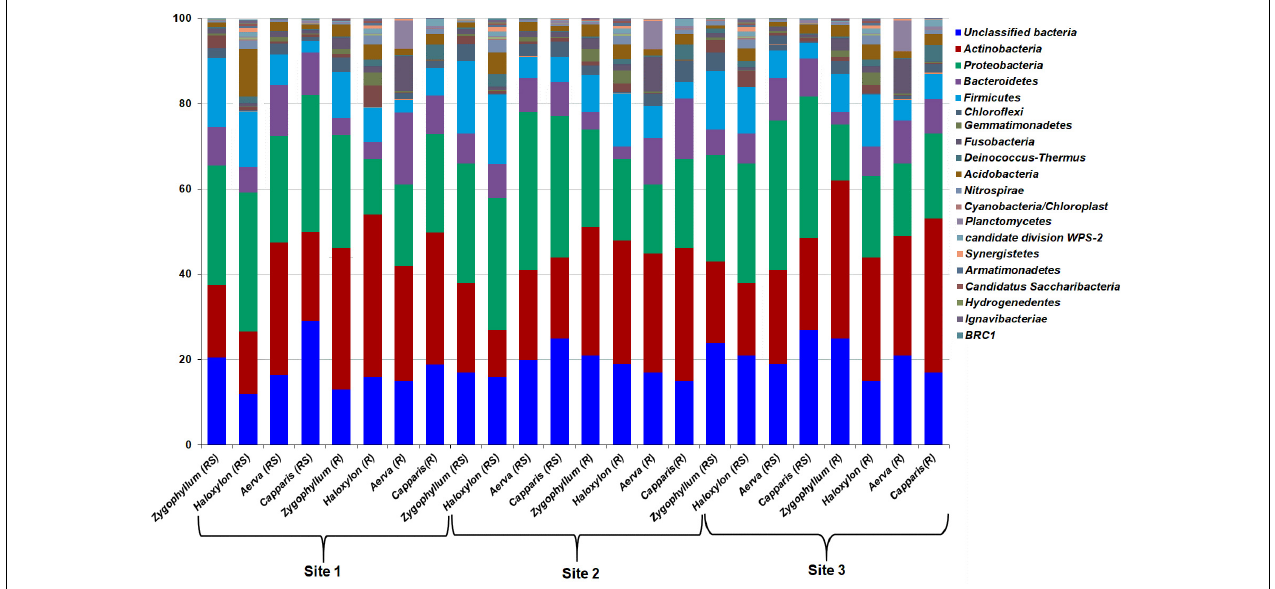
FIGURE 4 | Relative abundance of bacterial phyla from the rhizosphere (RS) and root endosphere (R) of desert halophytes collected from three sites of